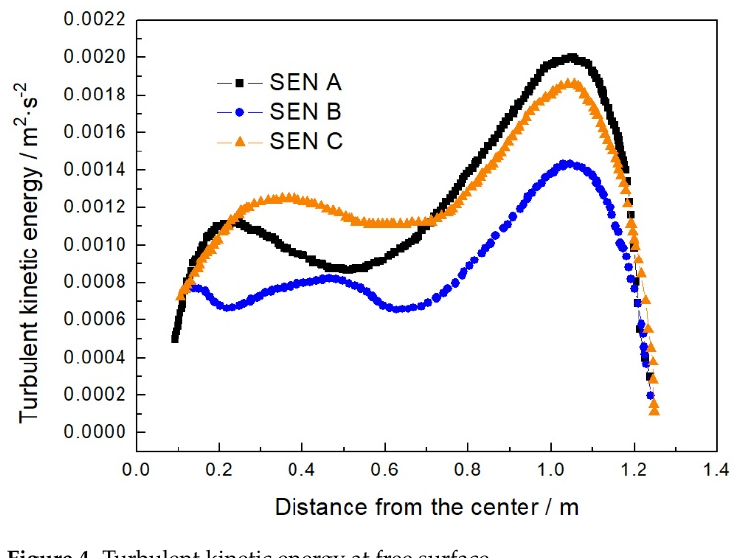
Figure 4. Turbulent kinetic energy at free surface.